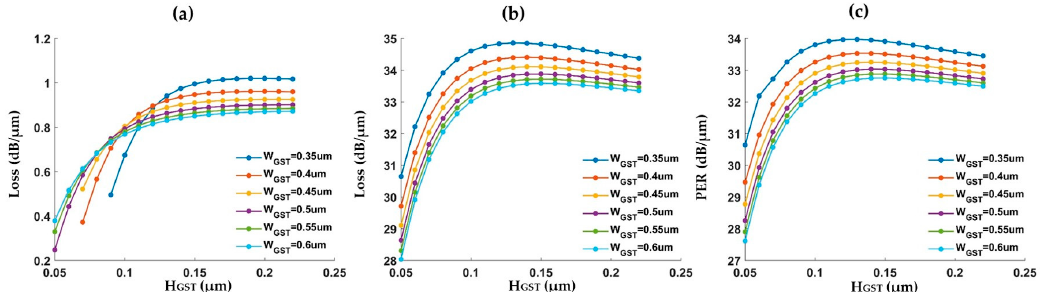
Figure 3. ( a ) Propagation loss of GST waveguide at the amorphous state. ( b ) Propagation loss of GST waveguide at the crystalline state. ( c ) Extinction ratio between the two states.